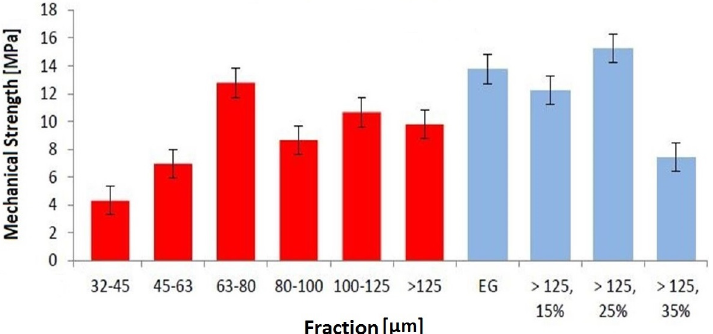
Figure 4. Mechanical strength of 3D printed